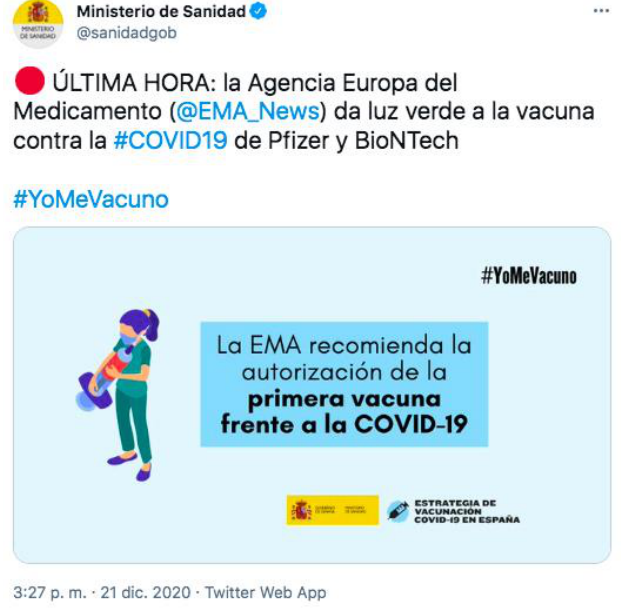
Figure 2. Image of the most shared tweet by healthcare professionals in #yomevacuno network.